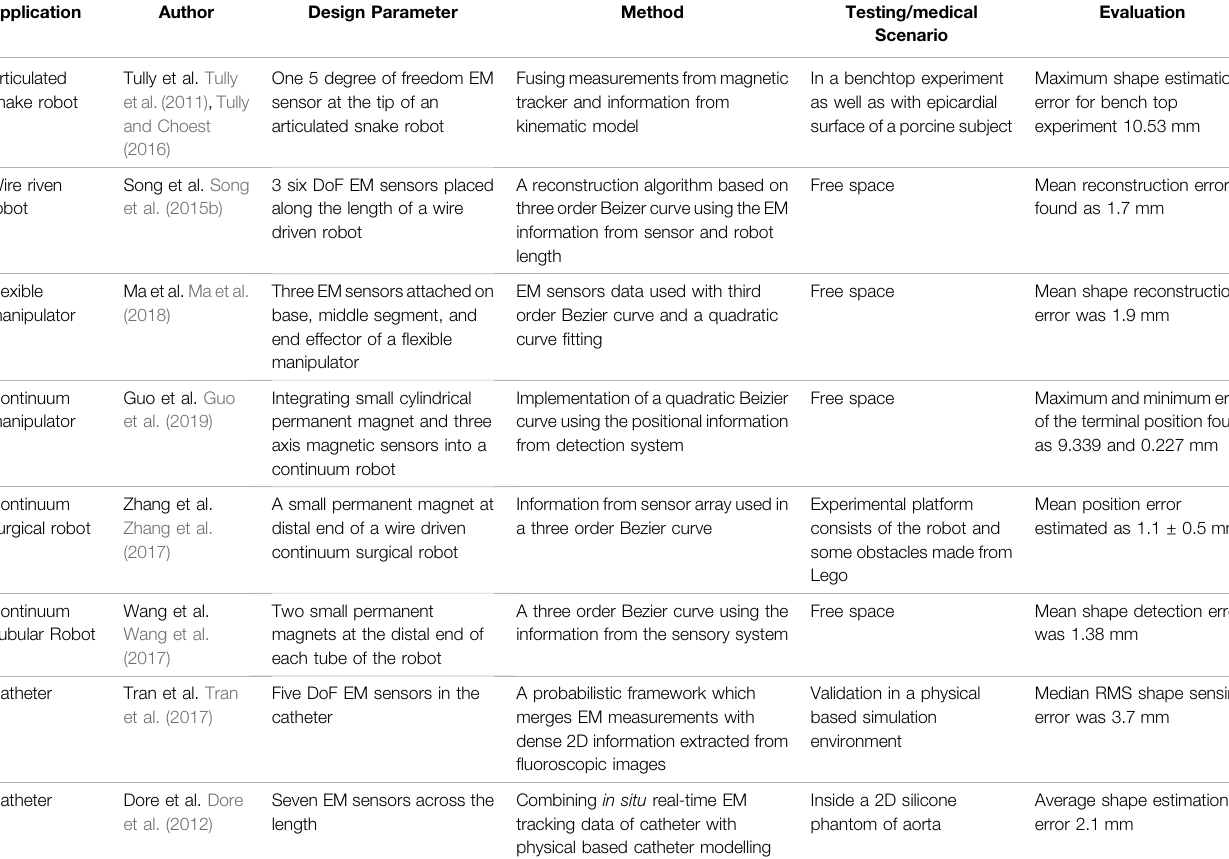
TABLE 2 | Summary of position-based shape reconstruction